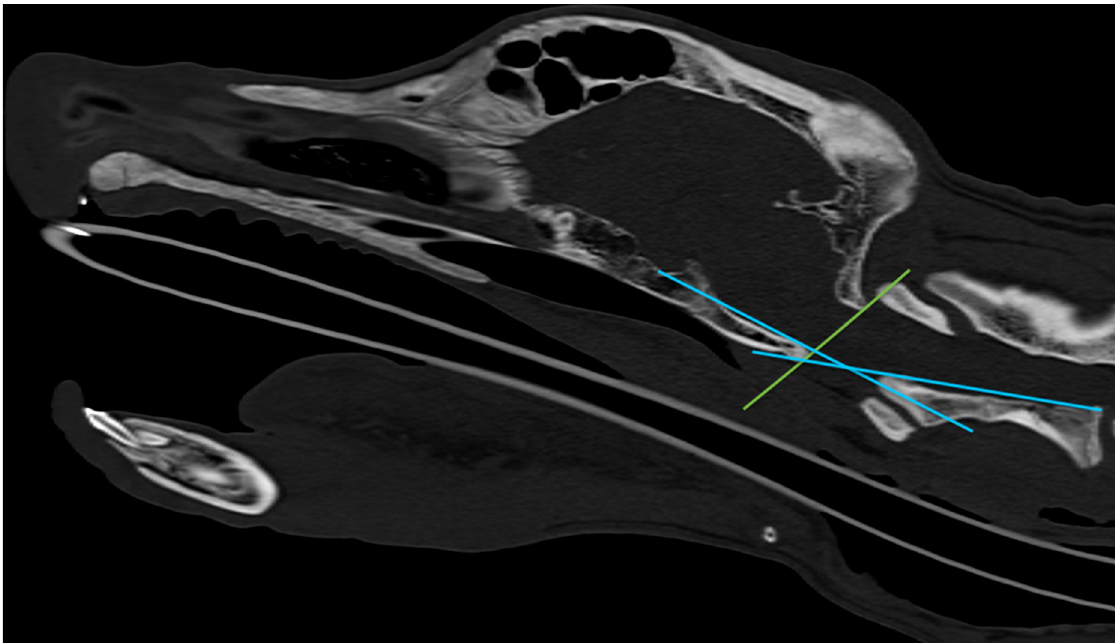
Fig 4. Analysis of physiologic relative position of the occipitoatlantoaxial joints. Sagittal CT image of the canine head with quantitative measurements as suggested by Waschk et al. [25]. McRae’s line (green): line drawn from basion to opisthion, no part of the dens or dorsal atlas arch is to cross this line. Wackenheim’s clivus baseline (rostral blue line): line drawn along the dorsal surface of the clivus, no more than one- third of the dens is to cross this line. Clivus canal angle (between both blue lines): angle formed by the junction of Wackenheim’s clivus baseline and the dorsal surface of the axis vertebral